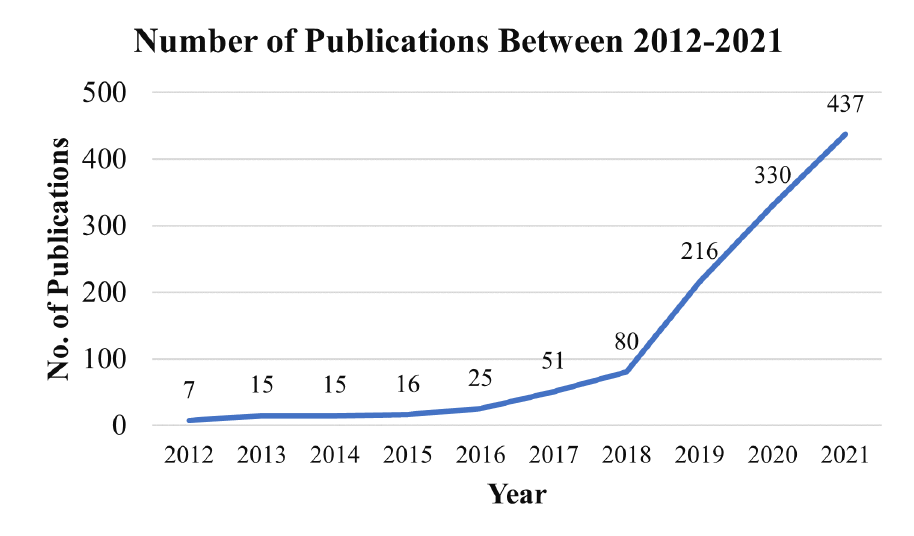
Figure 7. Publications of machine-learning-based disease diagnosis (MLBDD) by